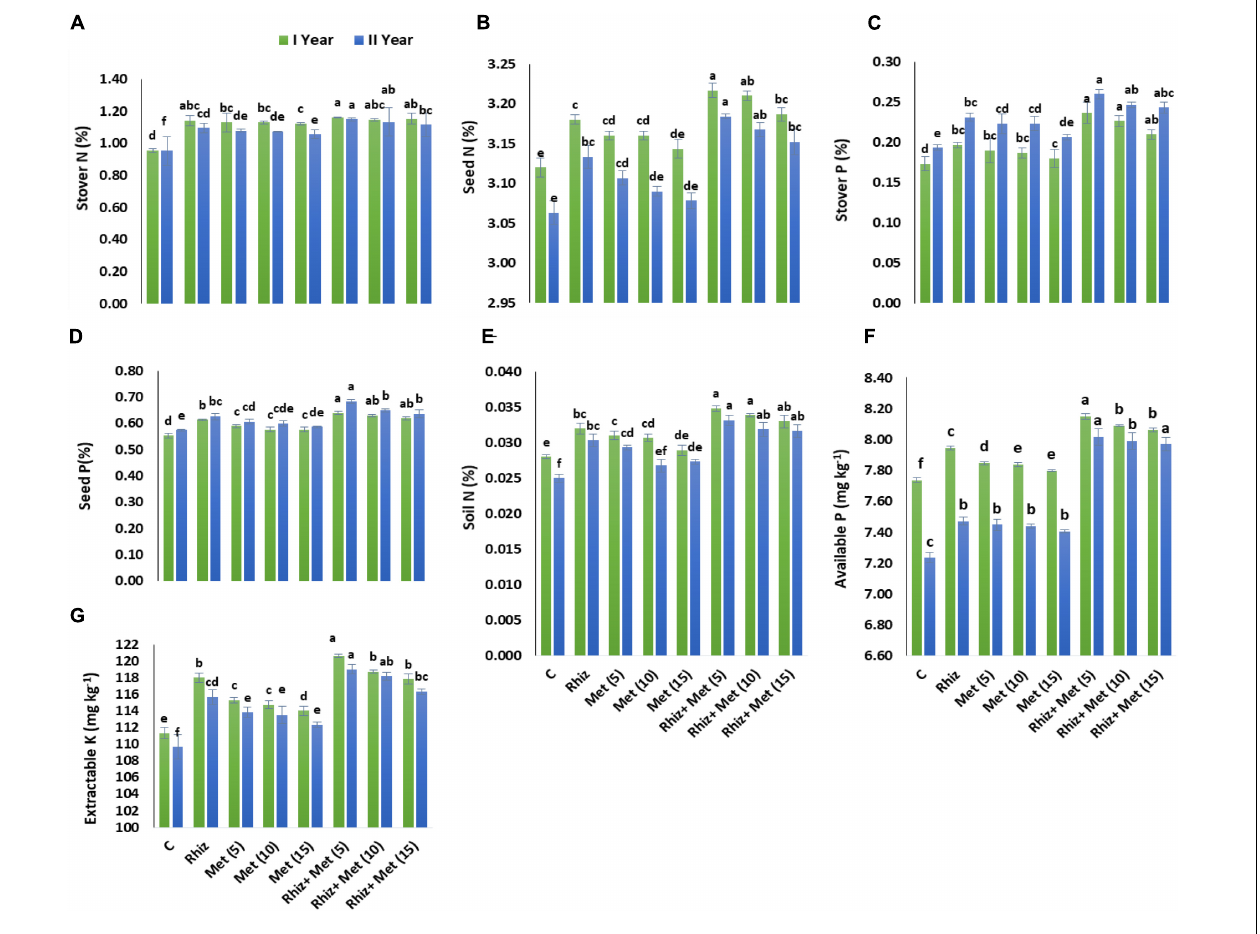
FIGURE 2 | Effect of seed inoculation and L-methionine application on nutrient contents. Y -axis bar shows standard error. (A) Stover N (%), (B) Seed N (%), (C) Stover P (%), (D) Seed P (%), (E) Soil N (%), (F) Available P (mg kg − 1 ), (G) Extractable K (mg kg − 1 ). Treatment abbreviations: control (C), Rhizobium (CPRH-10)